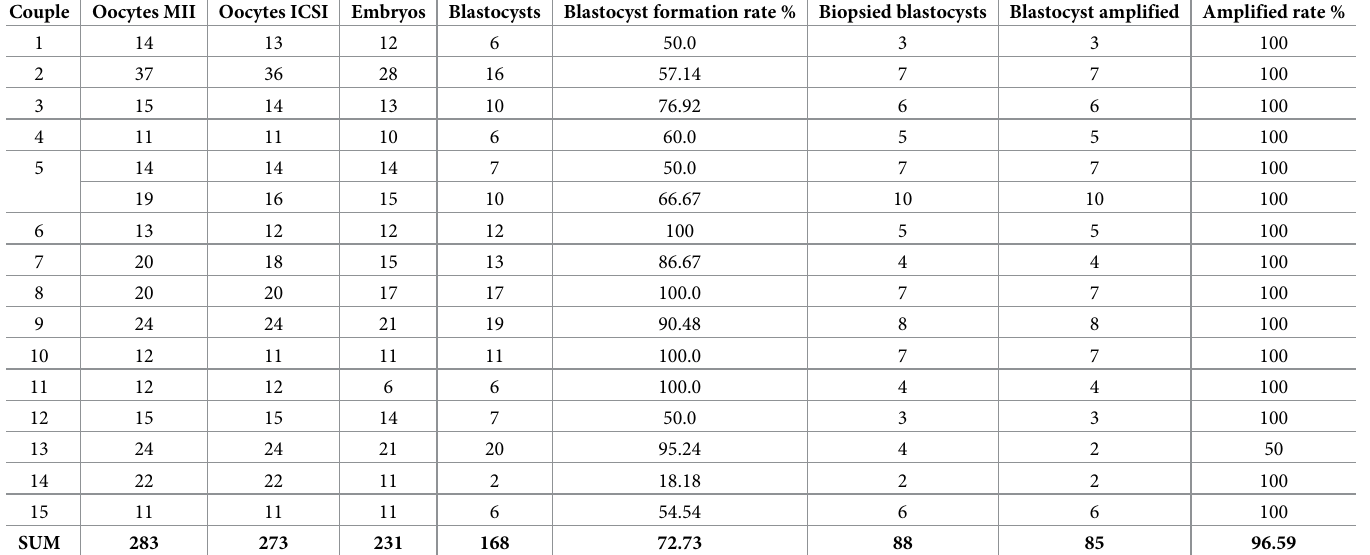
Table 3. Summary of the blastocyst development.